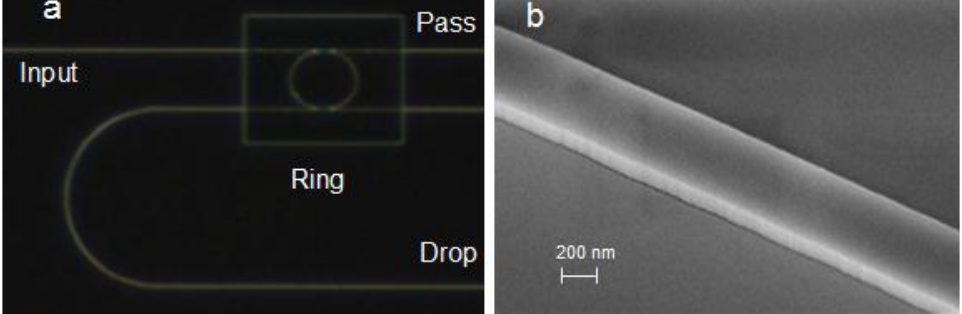
Figure 2. ( a ) Optical microscope image of the microring resonator; ( b ) SEM image of the waveguide.